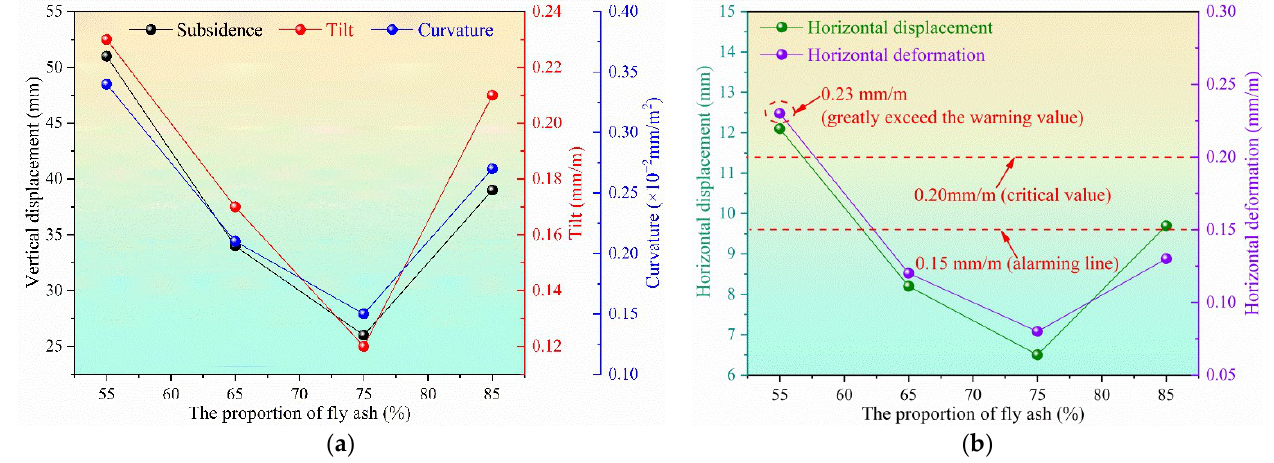
Figure 13. Numerical simulation results of the maximum values of five deformation indexes of the aquifuge with various proportions of fly ash. ( a ) The vertical displacement, tilt and curvature; ( b ) the horizontal displacement and horizontal displacement.